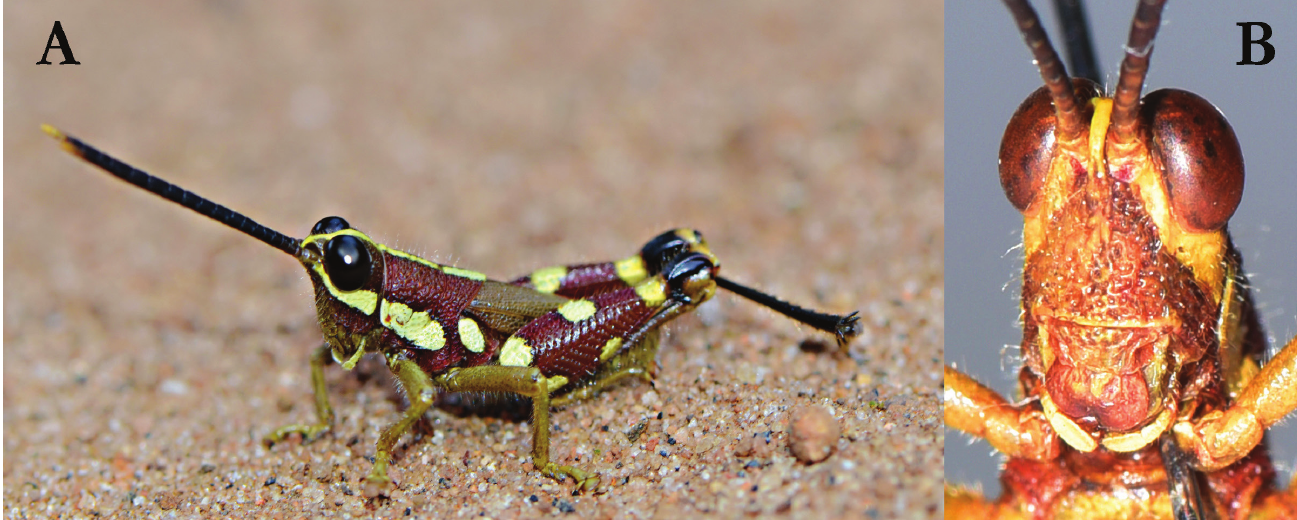
Fig. 4. Mopla guttata , male. A. Whole animal alive; the odd position of the right tibia is due to specimen being injured in capture. B. Oblique frontal view to show frontal ridge, for comparison with Fig. 2. Photo credit: D. Bhaskar and L.D.C.